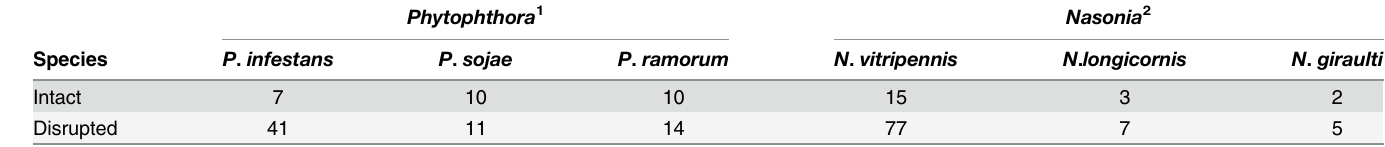
Table 3. Intact and disrupted U2 snRNA genes from Phytophthora (oomycete) and Nasonia (wasp).